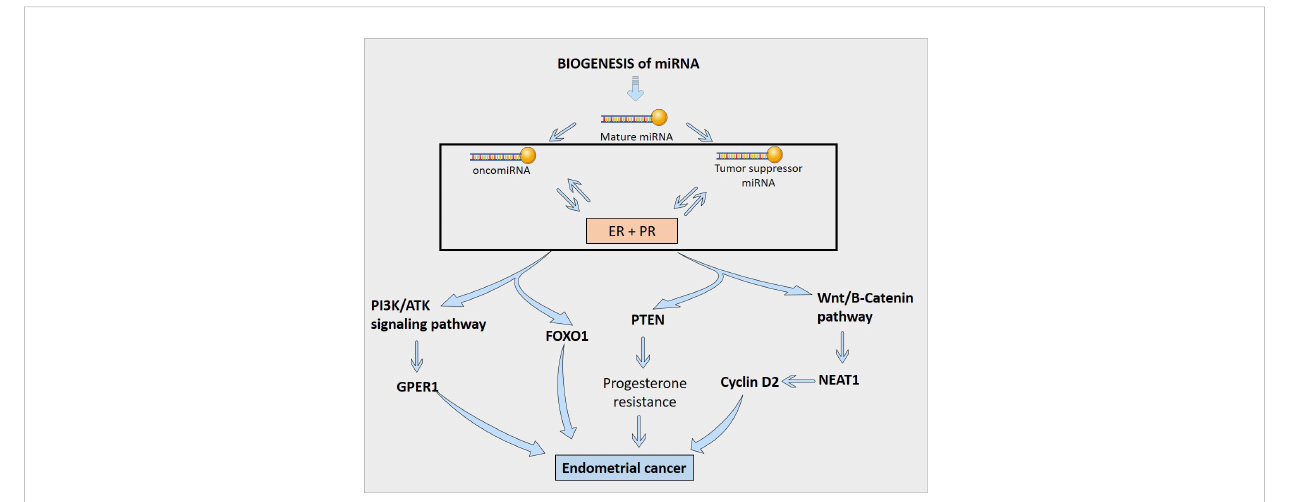
FIGURE 4 Interaction of miRNAs with sex steroid hormones in the regulation of Endometrial